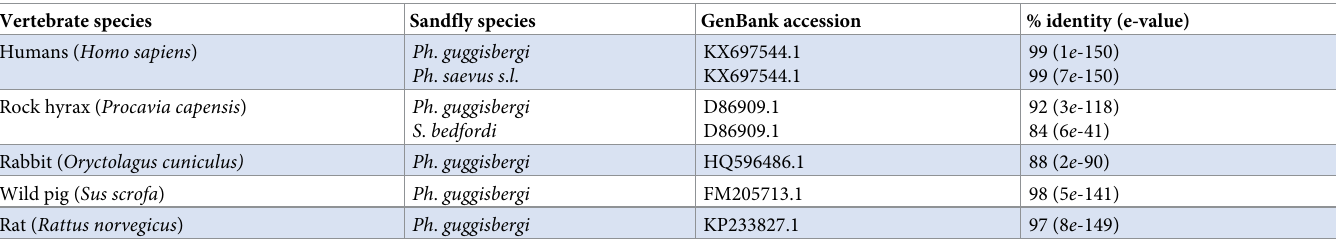
Table 3. Vertebrate species represented in sand fly